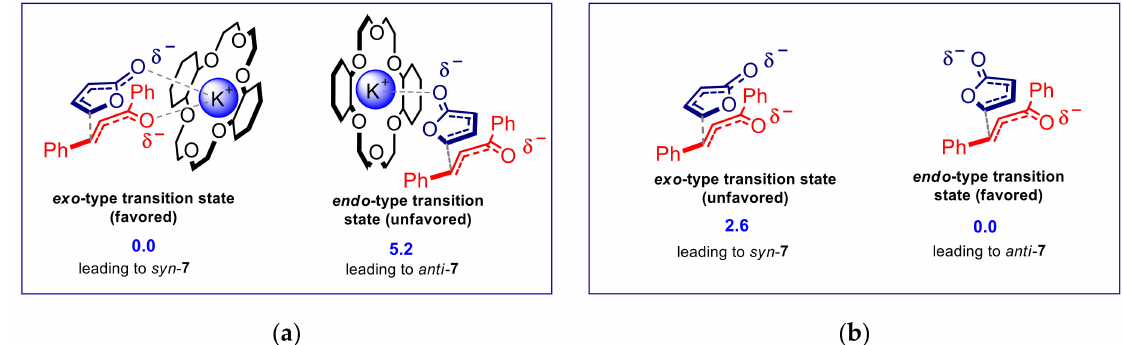
Figure 2. DFT calculations of the transition states for the VMMR of 2-trimethylsilyloxy furan and trans -chalcone. Relative energies of the transition states, expressed in kcal/mol, are shown in blue: ( a ) Chelated model of the transition state involving the dienolate/K + ⊂ dicyclohexane-18-crown-6 tight ion pair; ( b ) Model of the transition state involving the “naked” dienolate